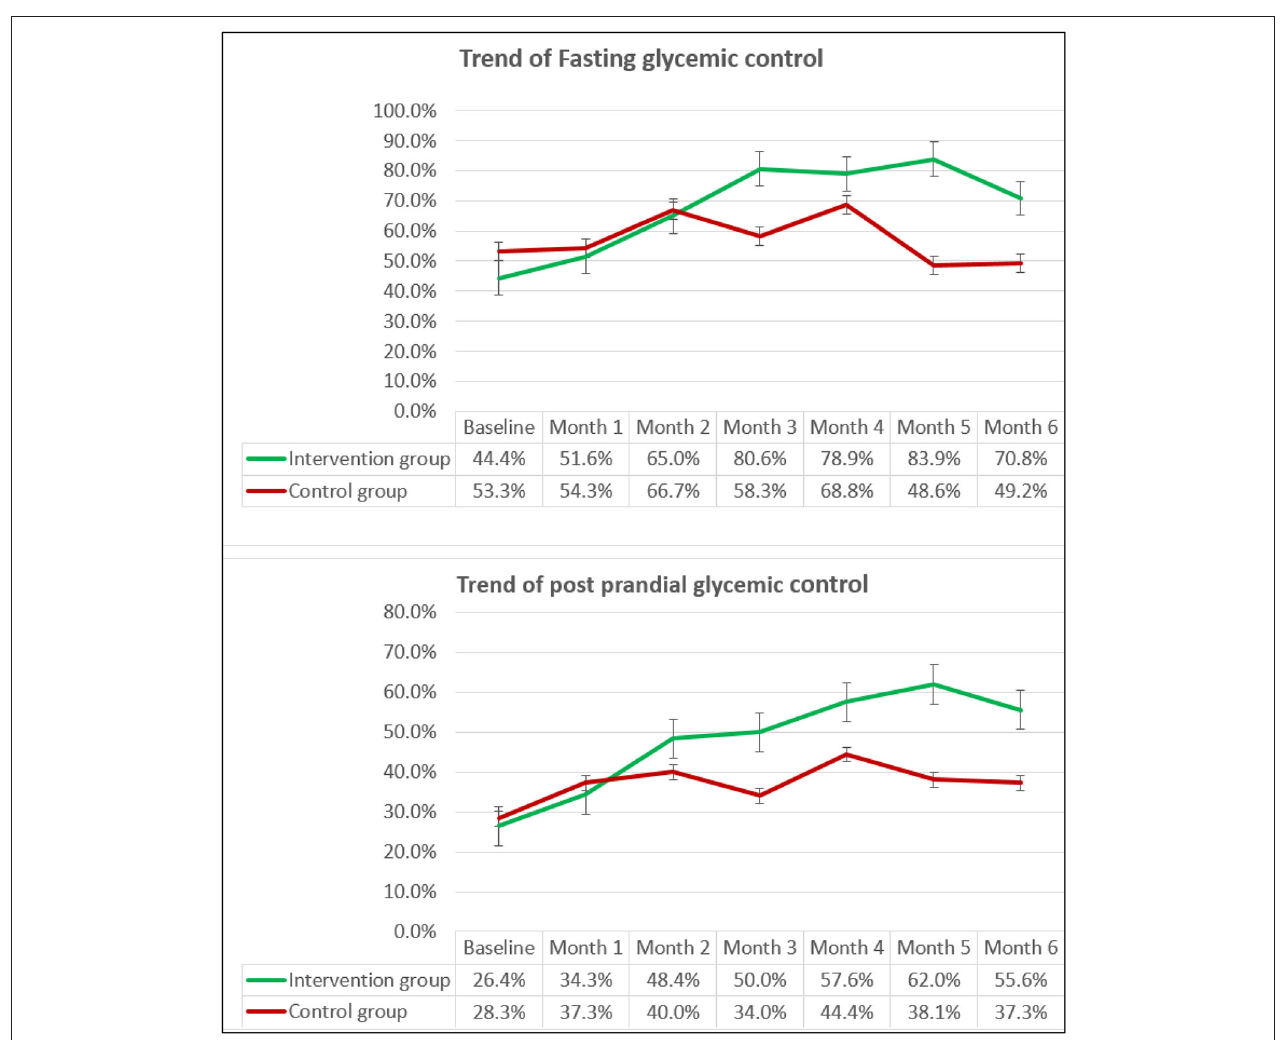
FIGURE 2 | The trend of proportion* of participants with Fasting and Postprandial glycemic control over the follow-up period. *Percentages are calculated excluding the missing values in both groups.